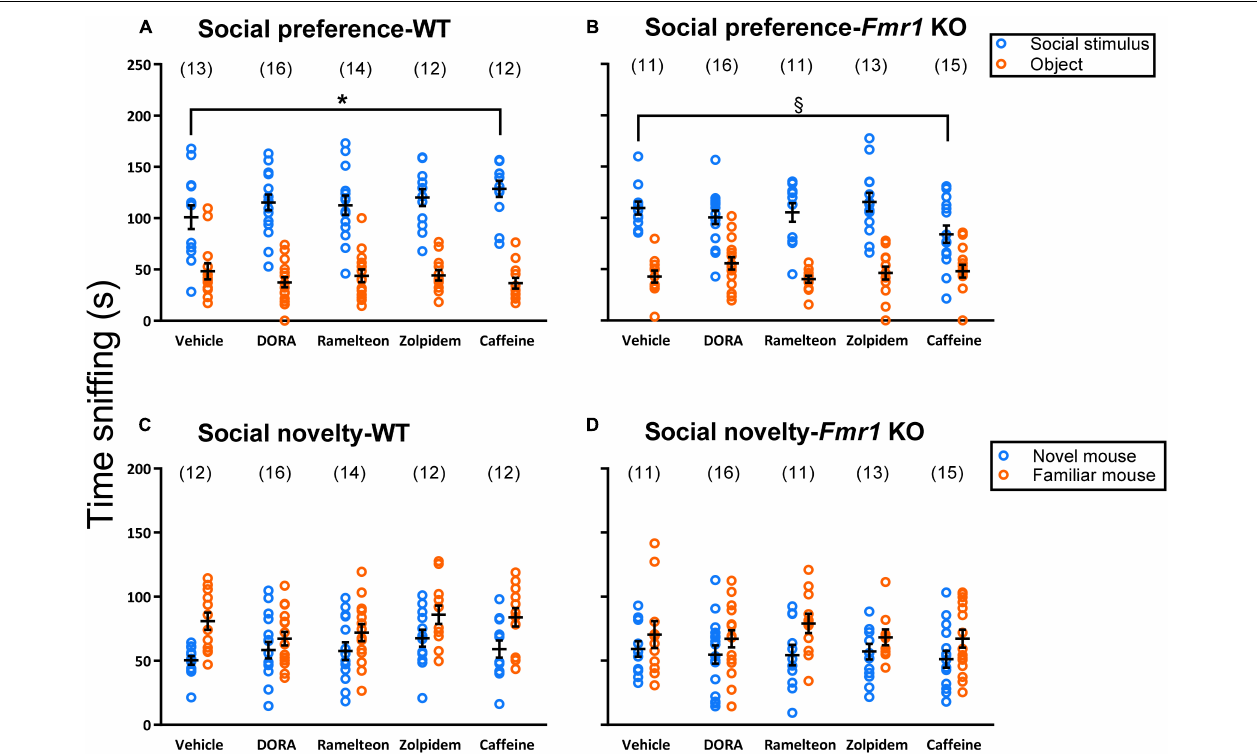
FIGURE 4 | Social Behavior testing. Eavh point represents the value in a single mouse. Lines represent means ± SEM for the number of animals indicated in parentheses. For social preference (A,B) , in the hypnotics analysis, only the main effect of chamber was statistically significant ( p < 0.001) showing that regardless of treatment or genotype, all mice showed a preference for the stranger mouse compared to the object. For the caffeine analysis, there was a statistically significant treatment × genotype x chamber interaction ( p = 0.011). Post-hoc t -tests showed that both genotypes showed a preference for the stranger mouse compared to the object. However, in WT mice, caffeine treatment resulted in increased sniffing time of the stranger mice compared to vehicle treatment ( p = 0.037). Conversely, in Fmr1 KO mice, caffeine treatment tended to reduce sniffing time of the stranger mouse compared to the vehicle group ( p = 0.052). The legend in B applies to both (A,B) . The legend in C applies to both (C,D) . *0.05 ≥ p ≥ 0.01; § 0.10 ≥ p ≥ 0.05; post-hoc t -test result. For preference for social novelty (C,D) , no meaningful statistically significant effects were found with the ANOVA. However, some interesting trends were noted and further investigated in Table 2 suggesting a possibility that ramelteon may improve social behavior in Fmr1 KO mice.